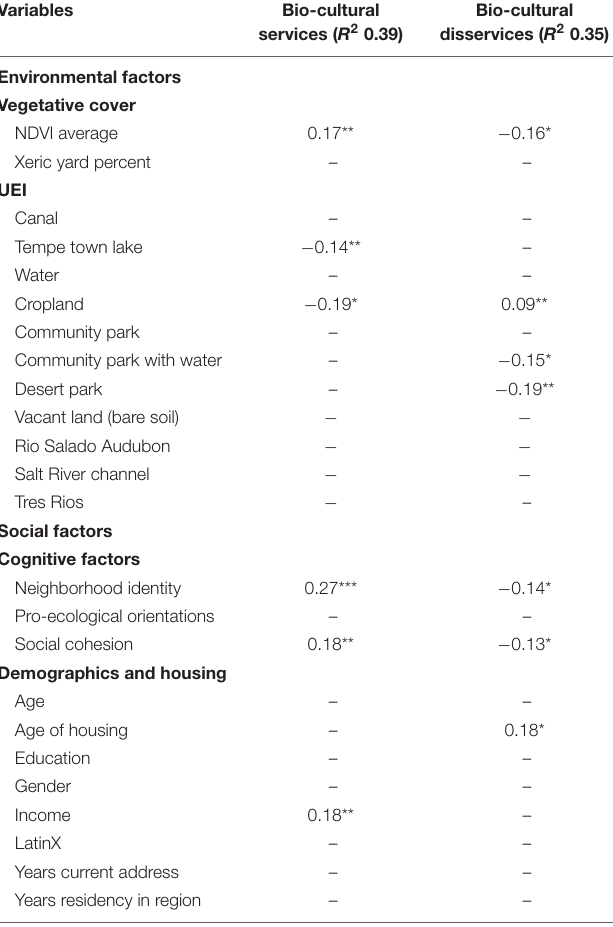
TABLE 8 | The combined model combines environmental and social variables for bio-cultural services and disservices.